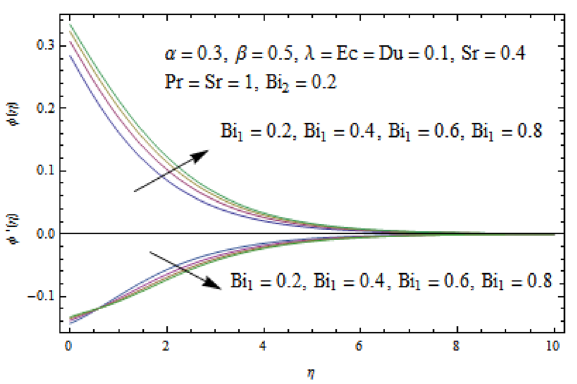
Fig. 16 Impact of Bi 1 on φ (η) & φ (cid:5) (η)